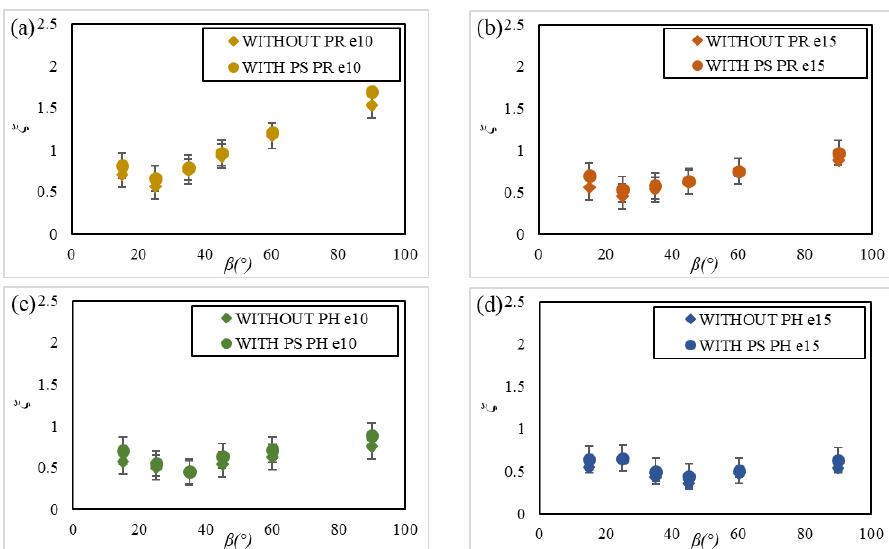
Figure 10. Comparison of measured head loss coefficients ξ with one and without the profiled shape (PS) support for ( a ) PR for a bar spacing of 10, ( b ) PR for a bar spacing of 15, ( c ) PH for a bar spacing of 10, and ( d ) PH for a bar spacing of 15, as a function of the angle of inclination β